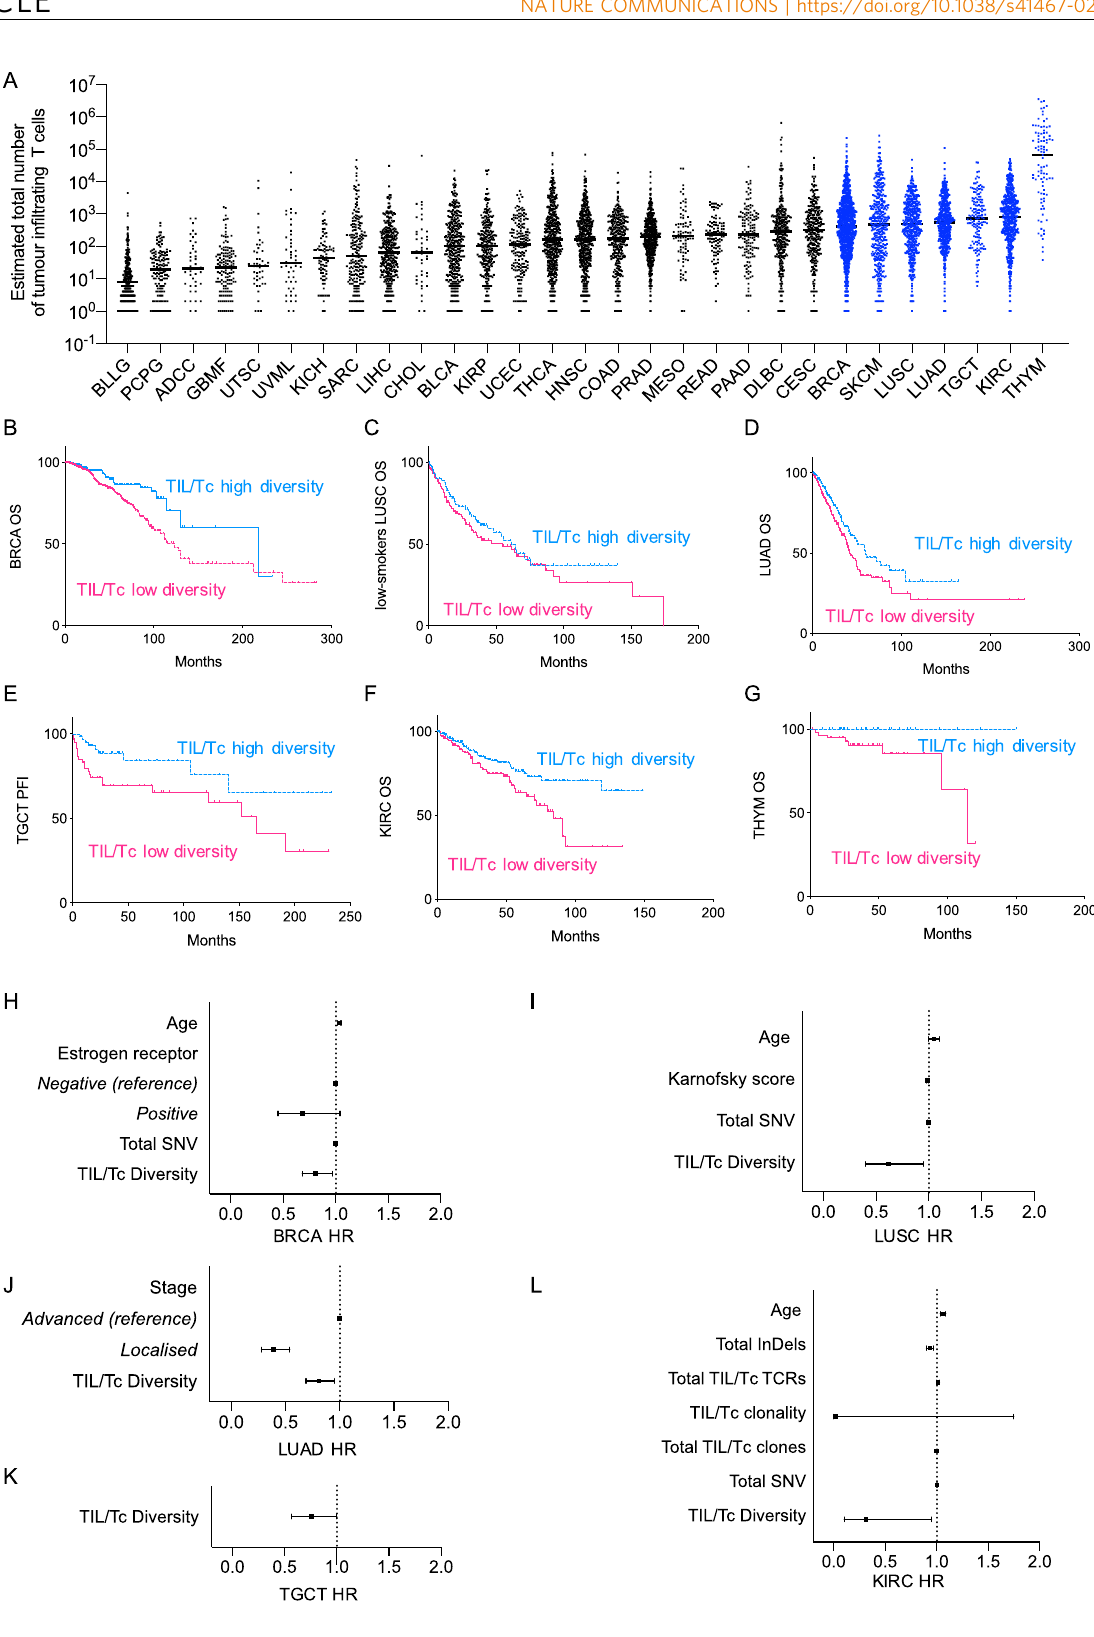
manufacturer ’ s instructions: brie fl y, after peroxidase block for 5min, the sections were incubated with the 22C3 antibody using a concentration of 1:50 for 60min at room temperature and then incubated for 30 min at room temperature with the linker antibody provided with the kit and speci fi c to the host species of the primary antibody; fi nally, the sections were incubated with a ready-to-use visualization reagent provided with the kit and consisting of secondary antibody molecules and horseradish peroxidase molecules coupled to a dextran polymer backbone. Sections